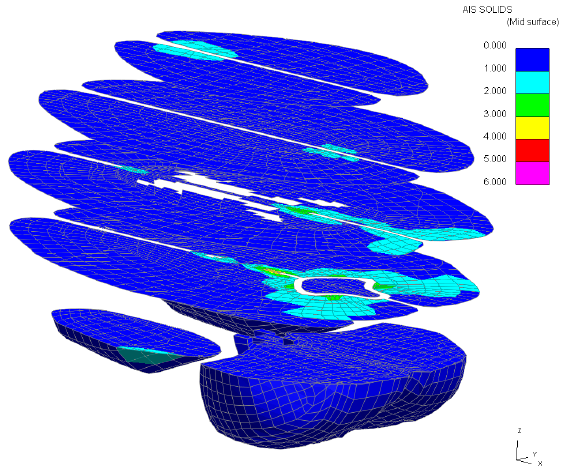
Figure 16. 3D slices of the brain (slices 20 mm apart).